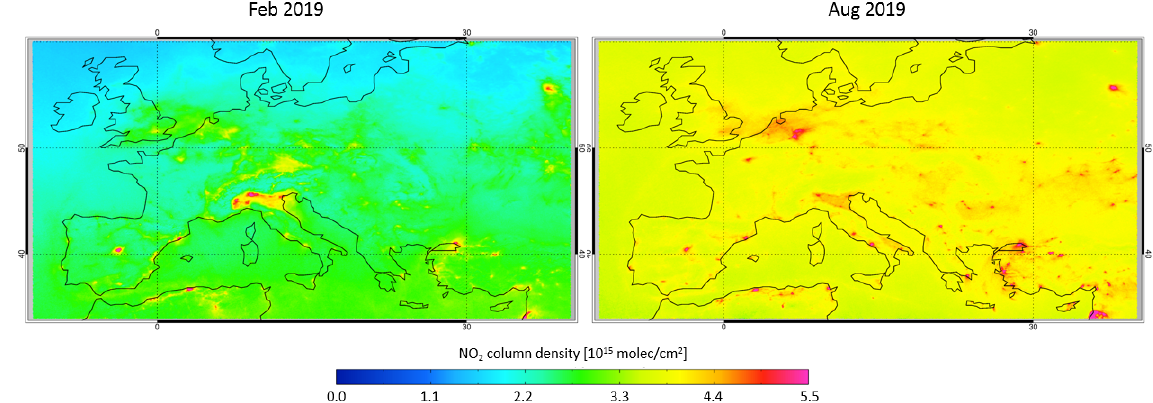
Figure 1. TROPOMI NO 2 slant columns (scaled by geometric AMFs) over Europe in February and August